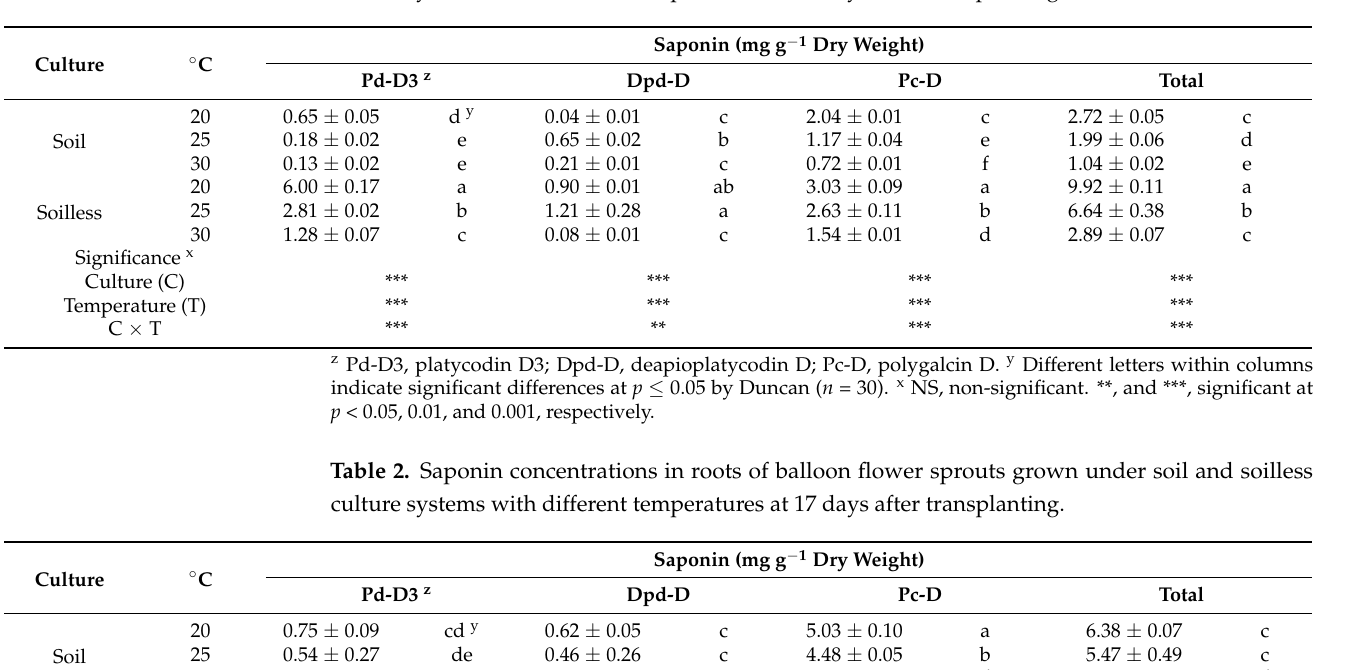
Table 1. Saponin concentrations in shoots of balloon flower sprouts grown under the soil and soilless culture systems with different temperatures at 17 days after transplanting.